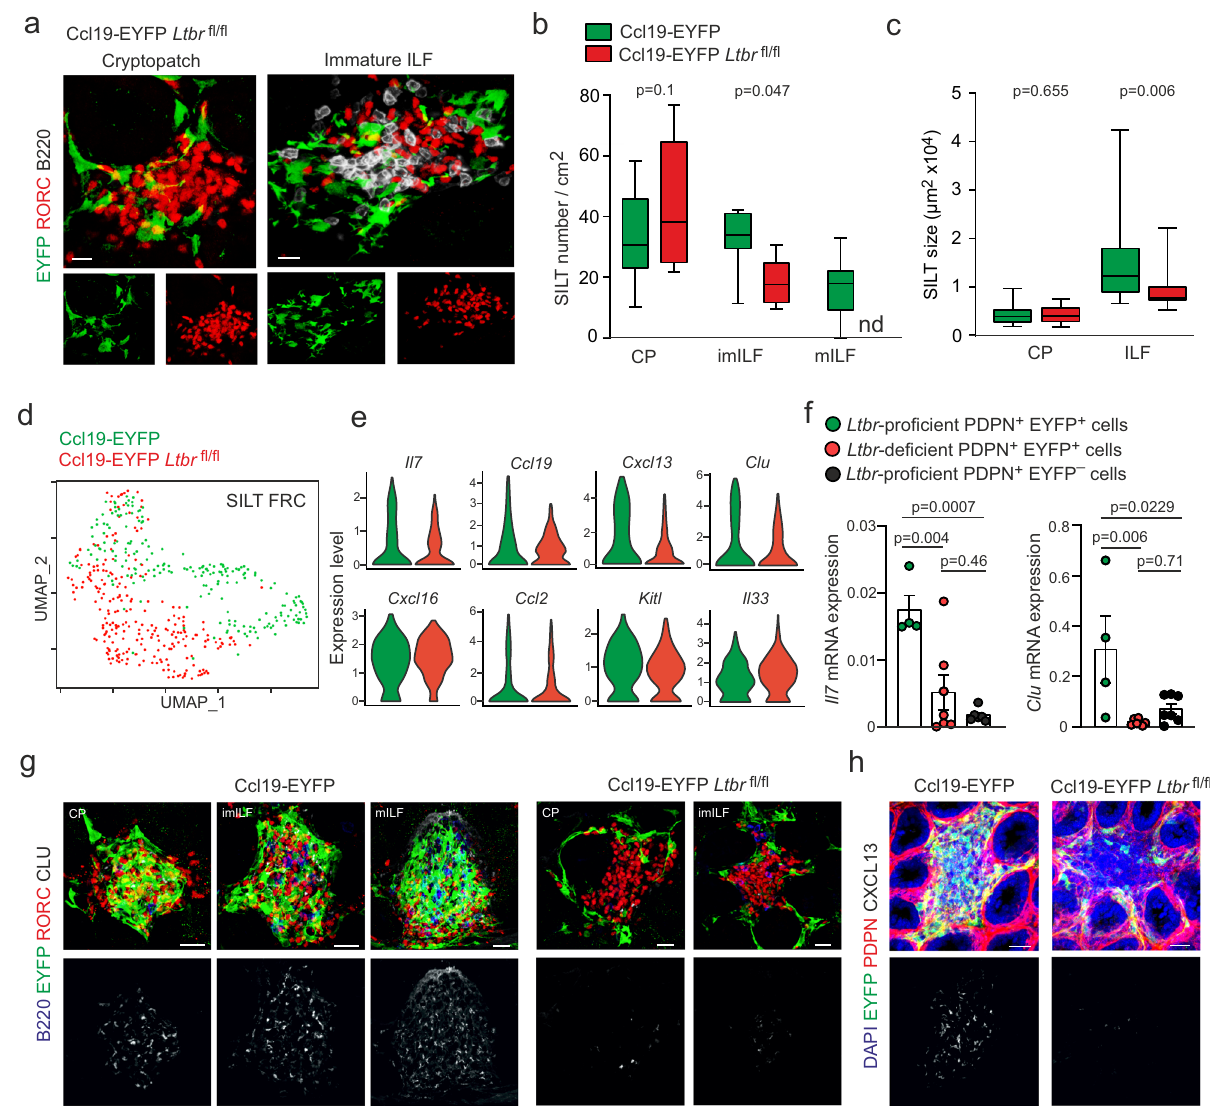
Fig. 2 FRC activation controls SILT maturation. a Representative confocal microscopy images of SILTs from adult Ccl19-EYFP Ltbr fl / fl mice stained with the indicated antibodies. Scale bar, 20 μ m. b Number of SILTs detected in the small intestine from adult Ccl19-iEYFP and Ccl19-EYFP Ltbr fl / fl mice. c Average SILT size in the small intestine of adult Ccl19-iEYFP and Ccl19-EYFP Ltbr fl / fl mice d UMAP of re-embedded SILT FRC from sorted EYFP + cells of adult Ccl19-iEYFP and Ccl19-EYFP Ltbr fl / fl mice. e Violin plots of the indicated gene expression pro fi les in different conditions based on scRNA-seq readout. f Relative expression of Il7 and Clu in FACS sorted PDPN + EYFP + SILT FRC and PDPN + EYFP - lamina propria fi broblasts from Ccl19-EYFP and Ccl19-EYFP Ltbr fl / fl small intestine, measured by real-time PCR. g , h Small intestinal sections from adult Ccl19-EYFP and Ccl19-EYFP Ltbr fl / fl mice analyzed by confocal microscopy after staining with the indicated antibodies. Scale bar, 20 μ m in ( g , h ). a Images are representative of at least six mice. b n = 8 and 8 mice from three independent experiments, median ± interquartile ranges. c n = 32 and 32 in CP and n = 37 and 13 in ILF from 8 mice in each condition with three independent experiments, median ± interquartile ranges. d , e ScRNA-seq data represents EYFP + SILT FRCs from adult Ccl19-EYFP and Ccl19-EYFP Ltbr fl / fl mice, n = 4 biological replicates. f n = 4, 7, and 7 from Ccl19-EYFP and Ccl19-EYFP Ltbr fl / fl mice, respectively, from three independent experiments, mean ± SEM. g , h Images are representative of at least four mice. Statistical analyses were performed using non-parametric two-tailed Mann – Whitney test ( c ) and one-way ANOVA with Tukey ’ s multiple comparison test ( b , f ). (Fig. 4b and Supplementary Fig. 6c, d). At the age of 8 weeks, all (Supplementary Fig. 6b). As expected, the formation of SILTs ILC subsets were reduced in untreated Ccl19-iEYFP Ltbr fl / fl mice was impaired in Ccl19-iEYFP Ltbr fl / fl mice in the absence of Dox treatment, i.e., with active Cre recombinase expression (Fig. 4b, compared to Ltbr -competent Ccl19-iEYFP mice (Supplementary no Dox). Consistent with data from the Ccl19-Cre model 35 , Fig. 6e). Blocking of Cre-mediated Ltbr -ablation through Dox continued ablation of the Ltbr gene in Ccl19-iEYFP Ltbr fl / fl mice treatment restored ILC homeostasis in Ccl19-iEYFP Ltbr fl / fl (no Dox) led to reduced Peyer ’ s patch formation (Supplemen- mice (Supplementary Fig. 6e). To reactivate Cre-mediated tary Fig. 6c). Dox treatment of pregnant dams and postnatal recombination in Dox-treated Ccl19-iEYFP Ltbr fl / fl mice, we ceased the provision of Dox via the drinking water at the age of provision of Dox via the drinking water (Dox on) prevented 8 weeks (Fig. 4a). After Dox removal for 2 weeks (Dox off 2 wk), Cre-mediated Ltbr -deletion and EYFP-expression and hence Cre-mediated recombination had started and fi rst EYFP + cells allowed for SILT maturation and Peyer ’ s patch formation NATURE COMMUNICATIONS| (2022) 13:2027